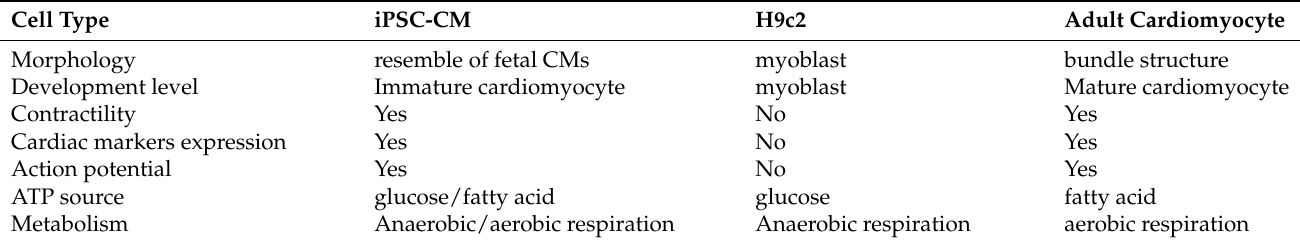
Table 1. The comparison of different sources of cardiac